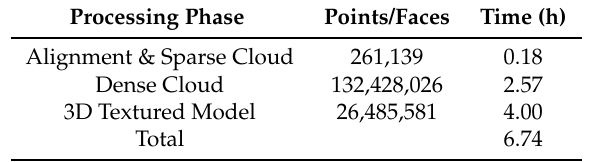
Table 5. PhotoScan processing details for final model generation.